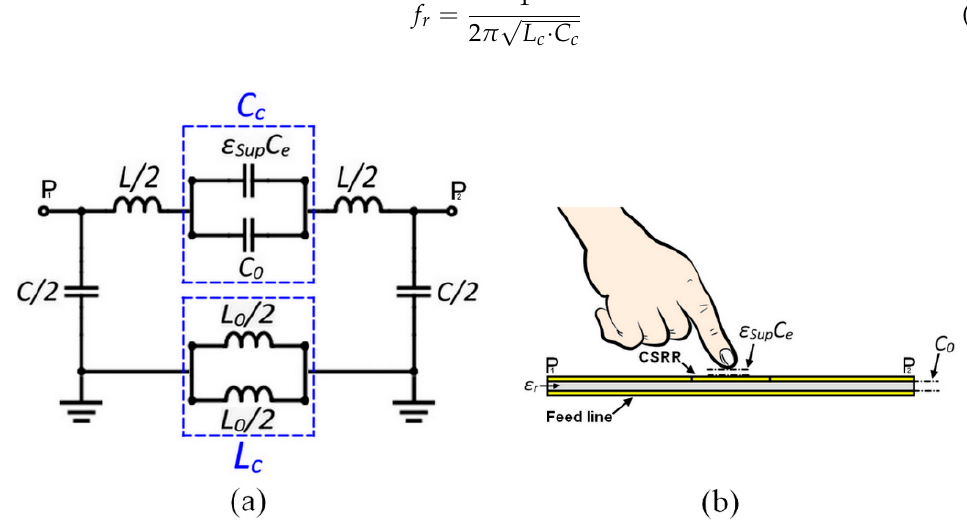
Figure 4. Equivalent circuit model of the proposed sensor in ( a ) and capacitive effects associated with the fingertip placement on the CSRR-sensitive area in ( b ).